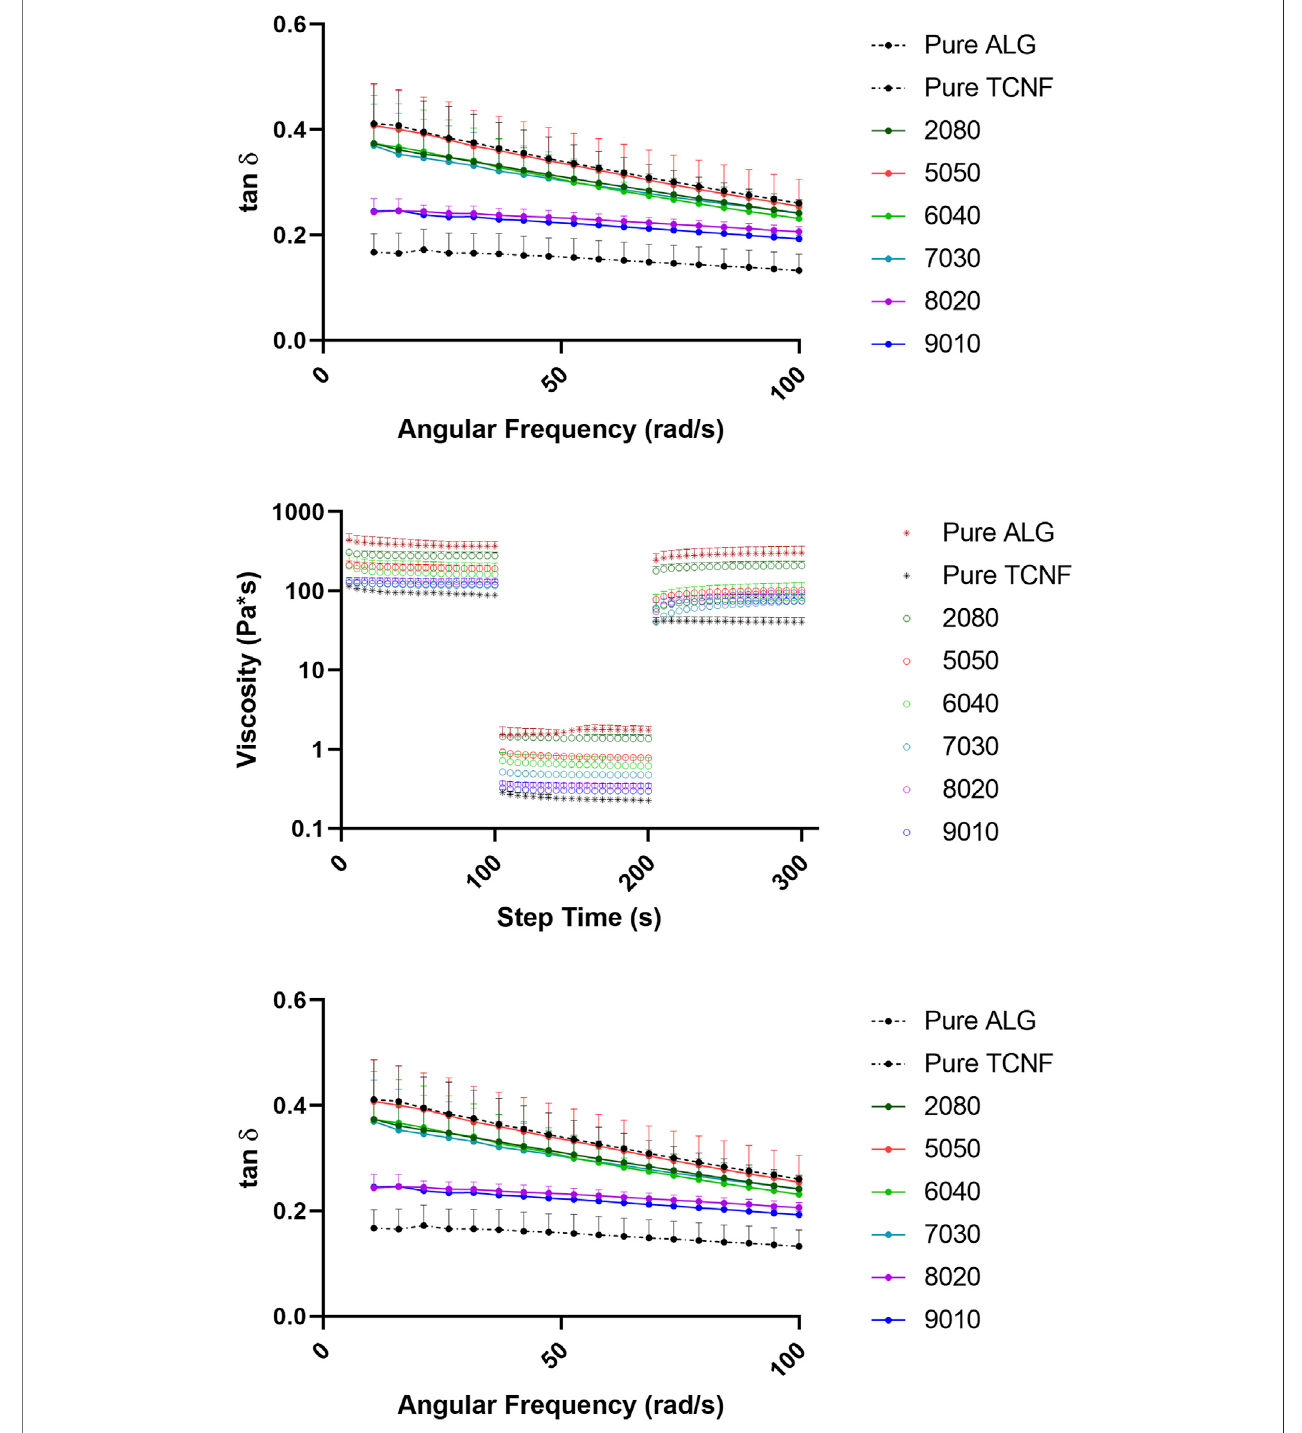
FIGURE 3 | The rheology behaviors of the TCNF/ALG precursors. (A) The steady state fl ow sweeps, strain rate from 0.001 to 1,000 s − 1 . (B) Three-step recovery andthixotropicbehavior,lowshearrateat1 s − 1 for100 sforinitialand fi nalstep,highshearrateat1,000 s − 1 for100 sformiddlestep. (C) LosstangentoftheTCNF/ALG precursors from 1 to 100 rad/s. The formulations are described in Table 1 .